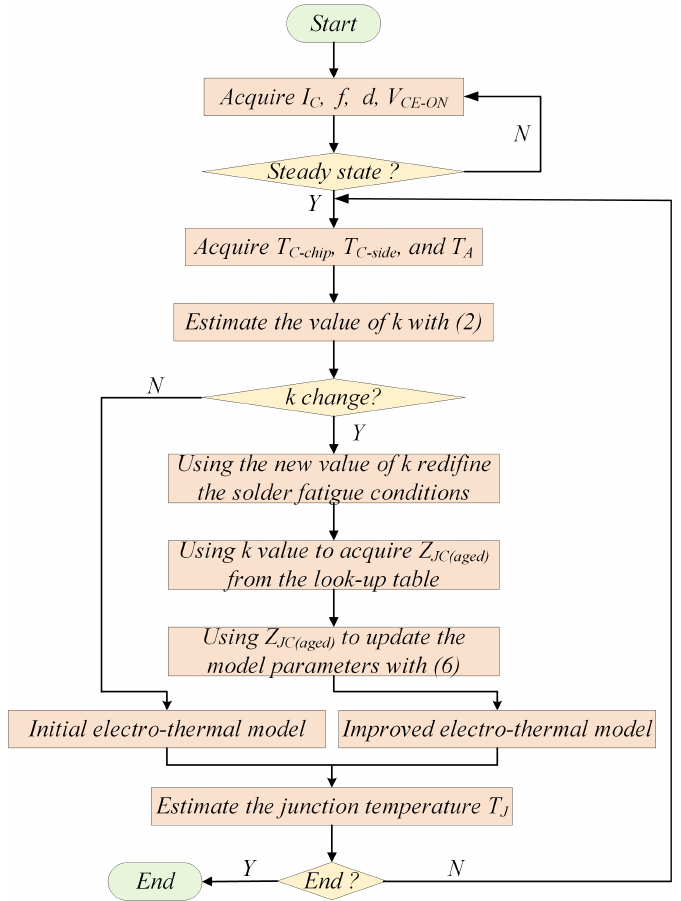
Figure 5. The flow chart of the proposed